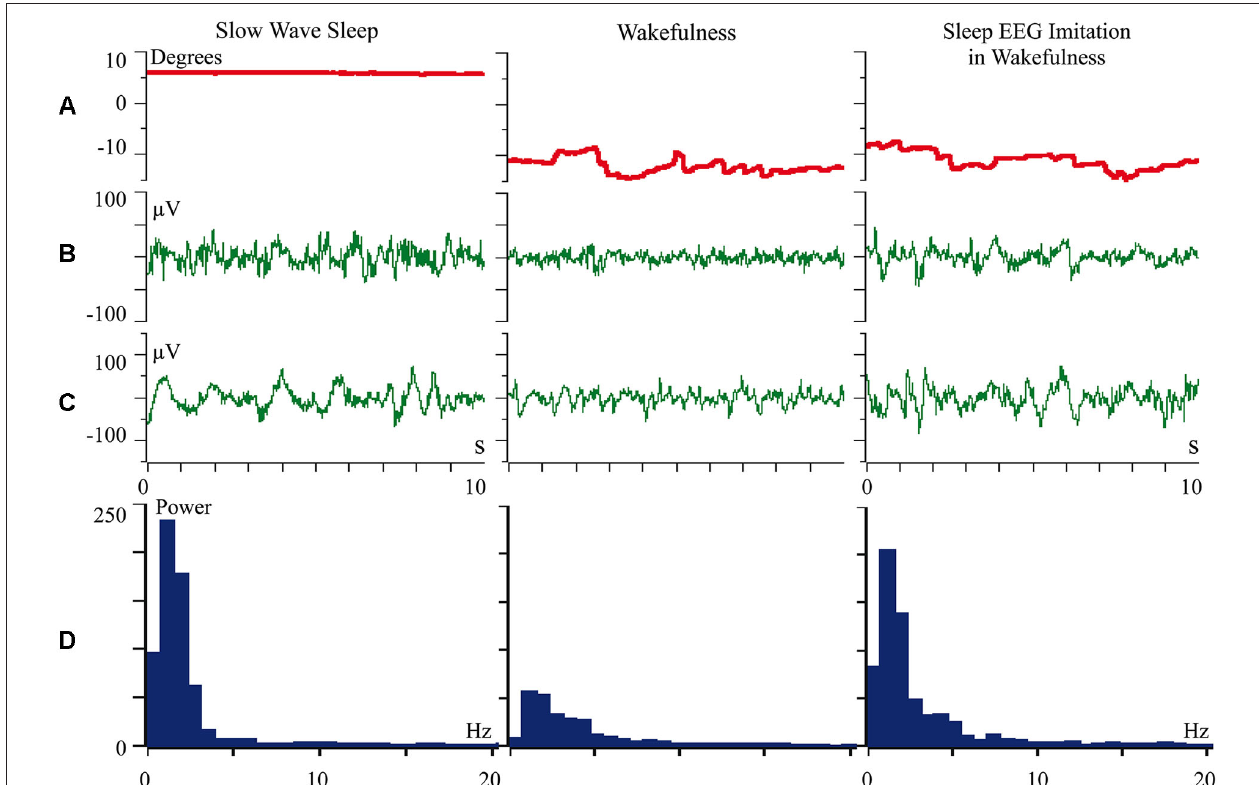
within the cortical visual area V1; (D) power spectrum of the local EEG presented above in panel C . All parameters were collected during SWS (left column), during passive wakefulness (middle column), and during the procedure of “sleep EEG imitation” by visual stimulation in wakefulness, which produced strong excitation of the cortical neurons recorded by the microelectrodes (right column). Technical details of the study in Pigarev et al.